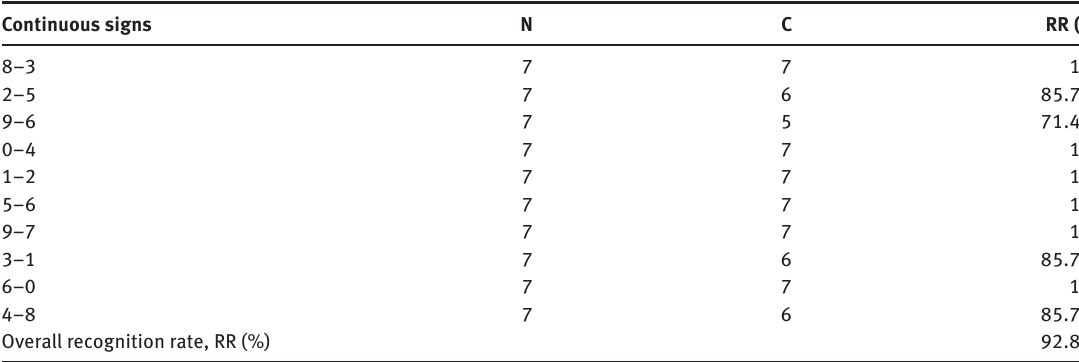
Table 2: Recognition Results for Continuous Sign Sequences Involving